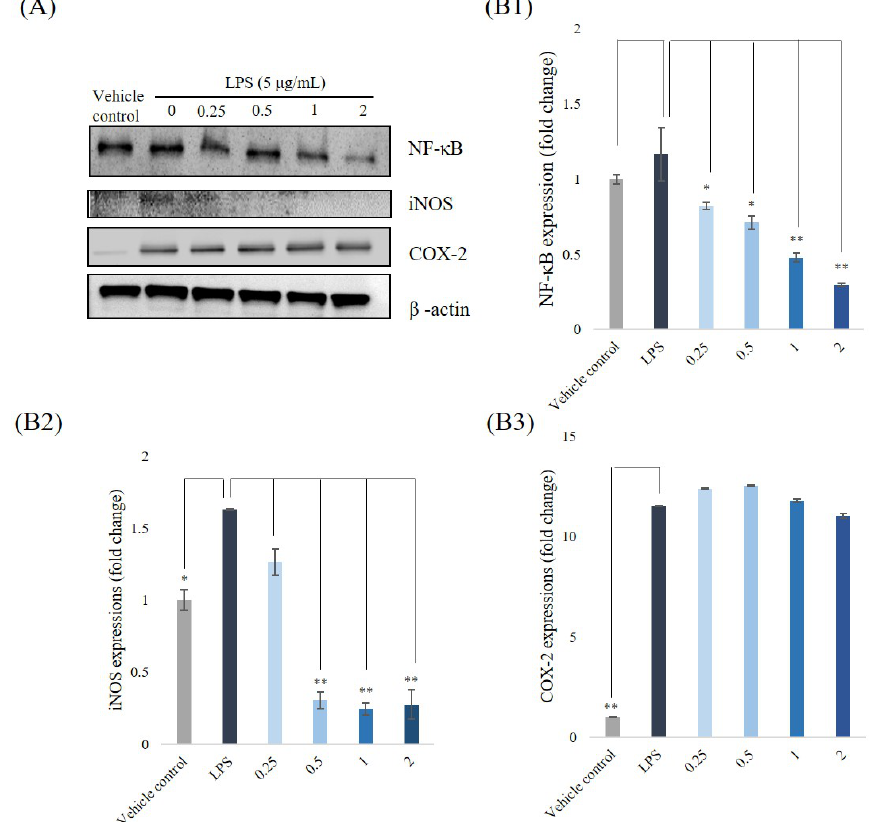
Figure 4. The inflammation-related protein expressions. ( A ) NF- κ B, iNOS, and COX-2 expressions in RAW 264.7 cells were pretreated with P. emblica samples (0.25–2 mg/mL) for 1 h, and then were stimulated with LPS (5 μ g/mL) for 6 h. ( B1 ) Protein quantification of NF- κ B ( B2 ) iNOS ( B3 ) COX-2 in western blotting. β -Actin was viewed as an internal control. *p < 0.05, **p < 0.01.